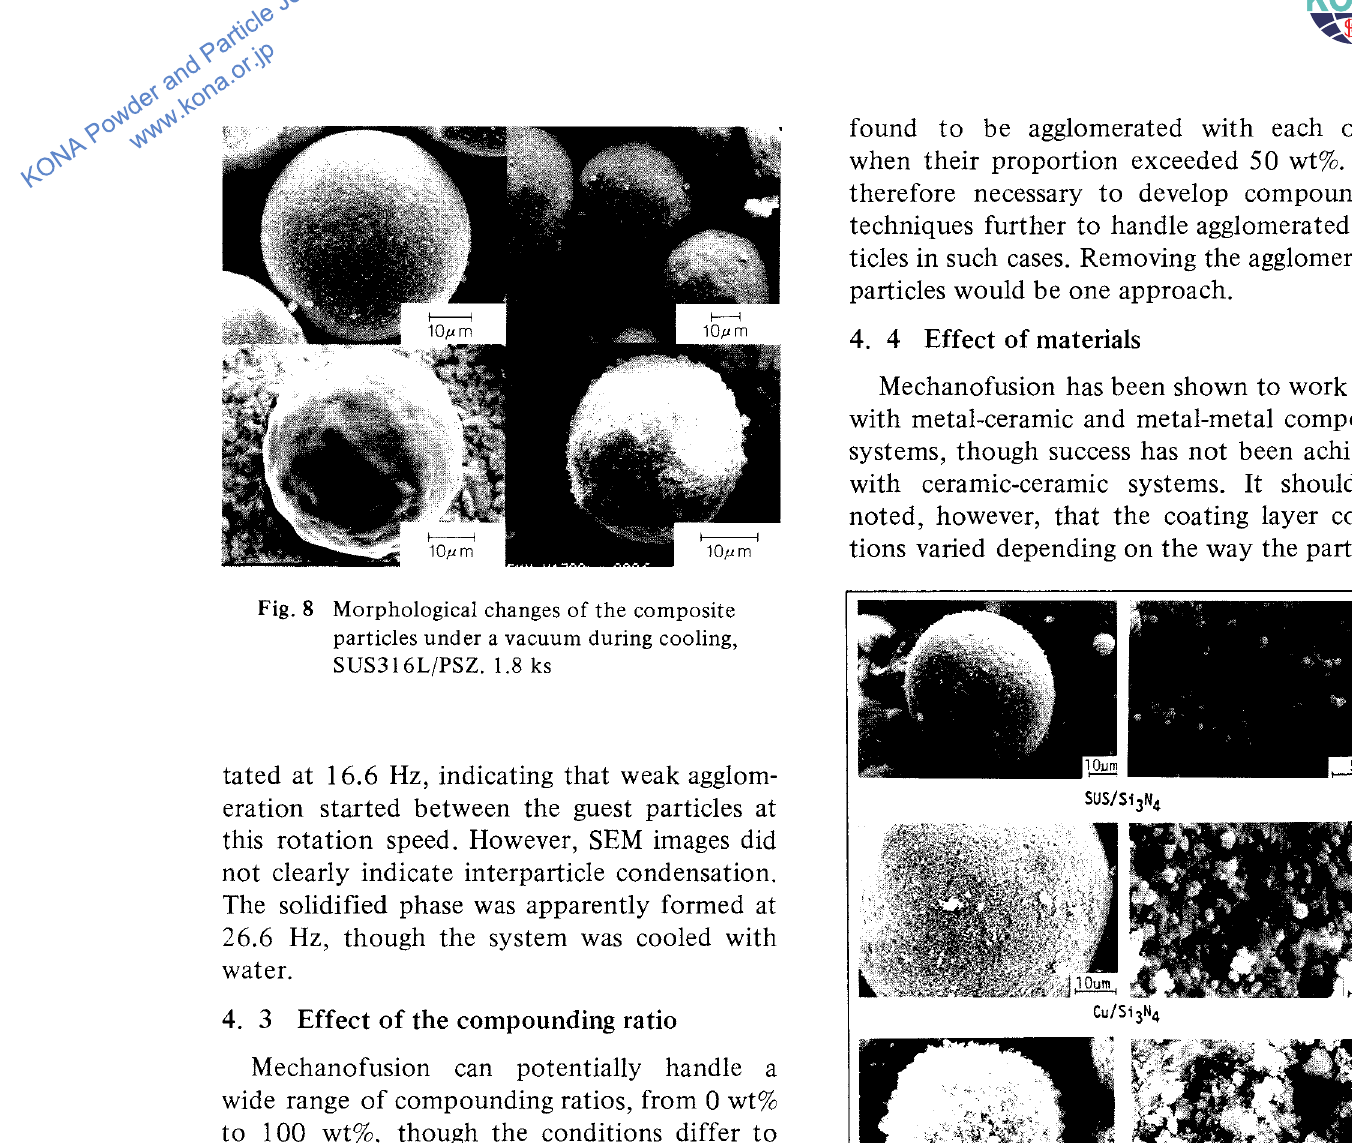
Fig. I 0 Composite particles with core particles of different